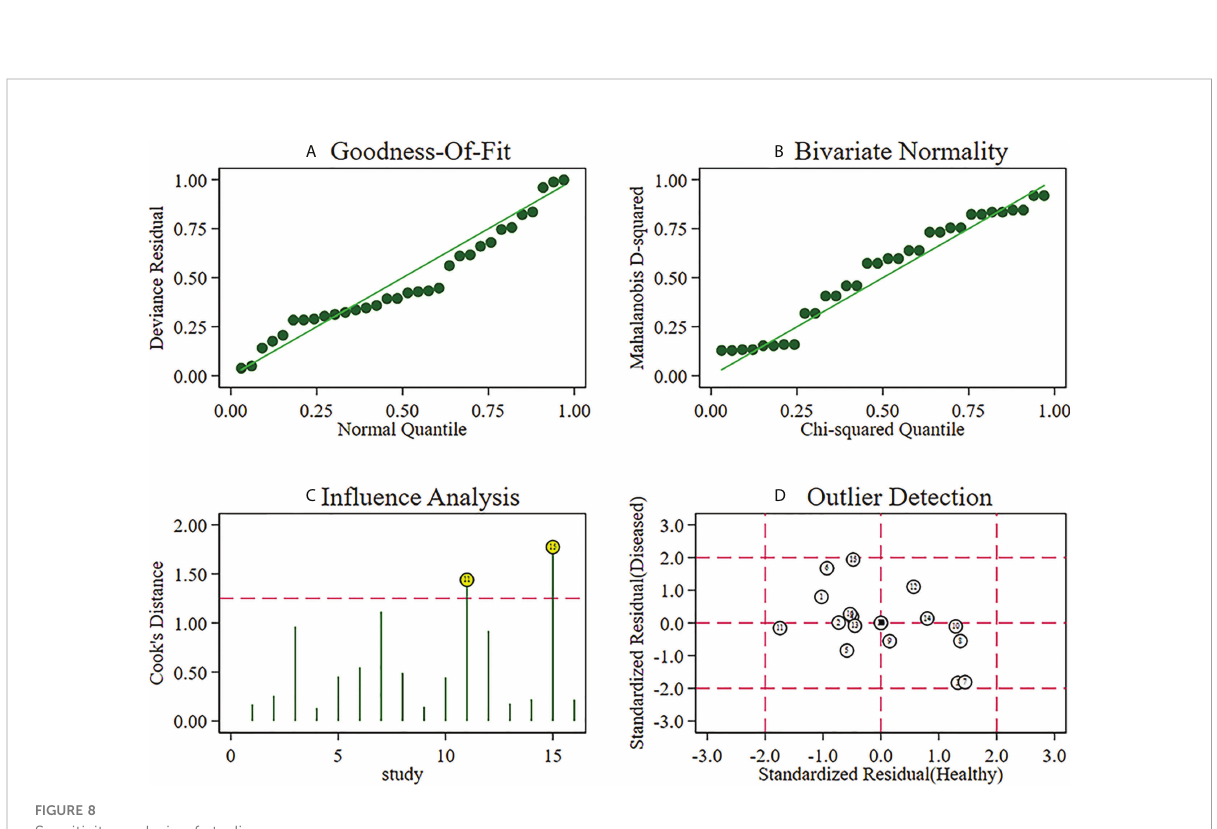
FIGURE 8 Sensitivity analysis of